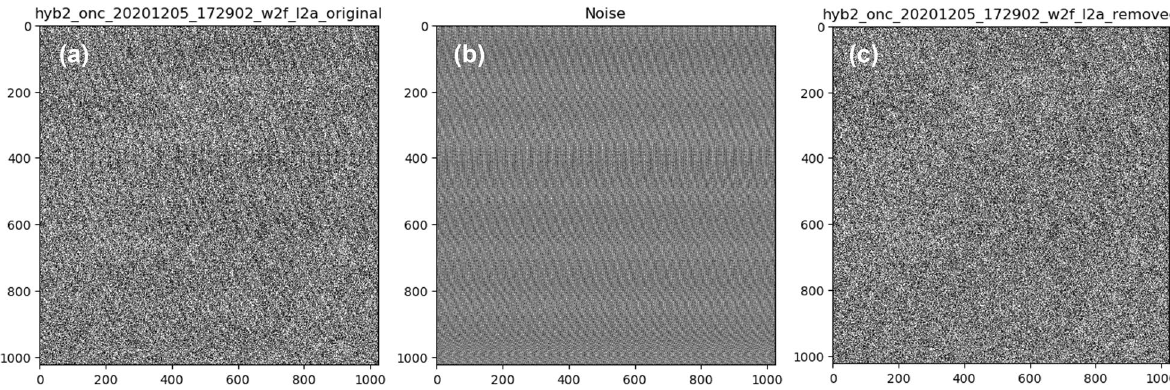
Fig. 16 a Example of an ONC-W2 image when the capsule is expected to have maximum thermal emission. b Synthetic image generated from the top-10 Fourier components in ( a ). c Noise reduced image derived from ( a , b )